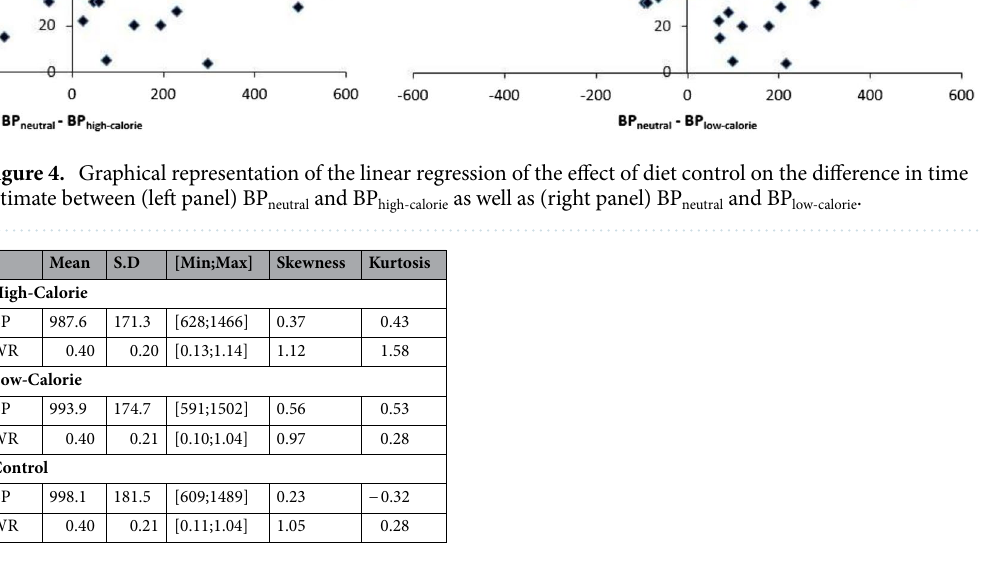
Table 1. Descriptive statistics for the computed BP and WR associated with each picture condition.